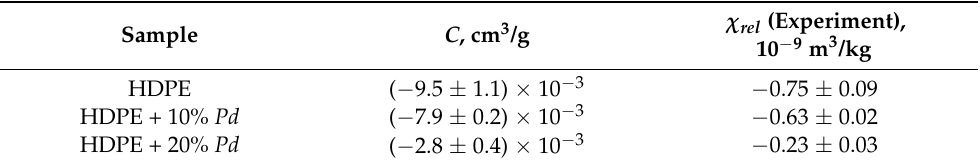
Figure 10. Magnetization curves the palladium containing composites. 1-HDPE, 2-the sample HDPE + 10 wt.% Pd , 3-the sample HDPE + 20 wt.% Pd . Obtained data for magnetic susceptibility are shown in Table 5. Table 5. Parameters of linear regression and magnetic